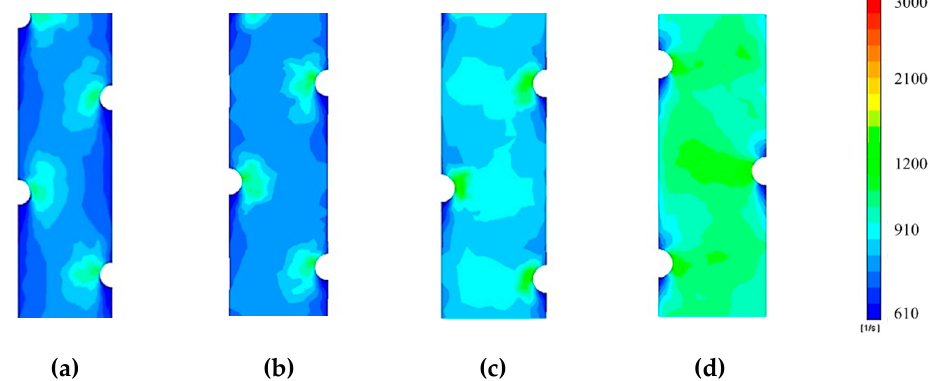
Figure 7. Shear rate contours of membrane surface inside PF channel geometry simulated: ( a ) total chamber contour of membrane rate at a CFV 0.10m/s and 0% occlusion, ( b ) 25% occlusion, ( c ) 55% occlusion and ( d ) 70% occlusion.